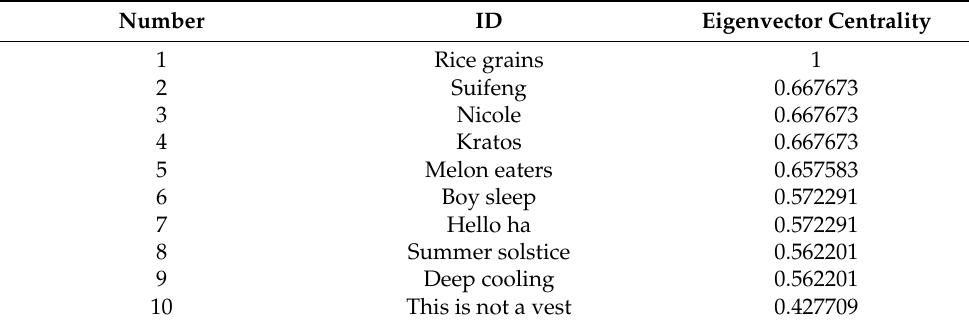
Table 3. Statistics of users’ eigenvector